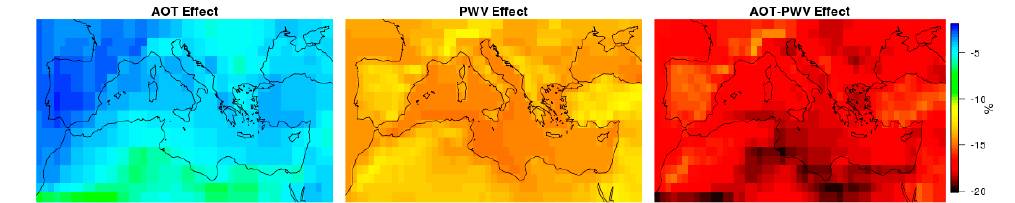
Figure 6. Distribution of averaged AOT effect, PWV effect and AOT-PWV effect on shortwave radiation at the surface over the Mediterranean basin during the period 2000–2018. All figures have the same scale.